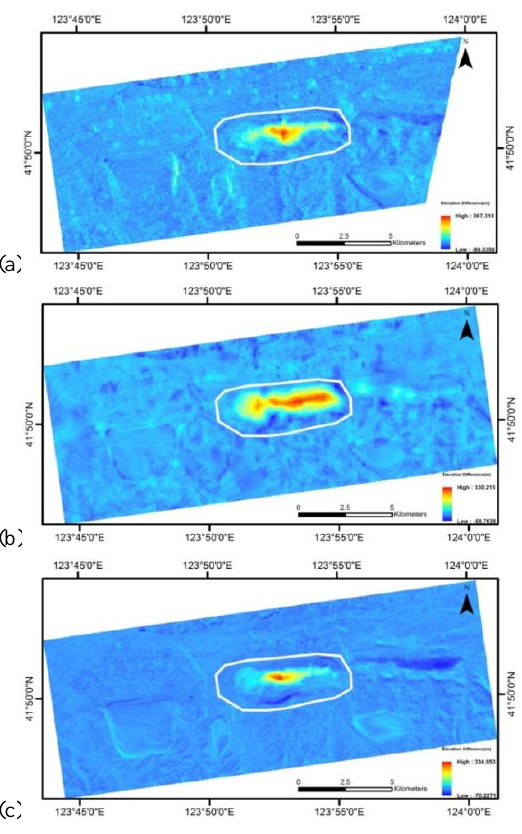
Figure 4 Elevation changes between ZY-3 DEMs and ASTER GDEM. (a) ZY-3 DEM in 2013 and ASTER GDEM; (b) ZY-3 DEM in 2014 and ASTER GDEM; (c) ZY-3 DEM in 2015 and ASTER